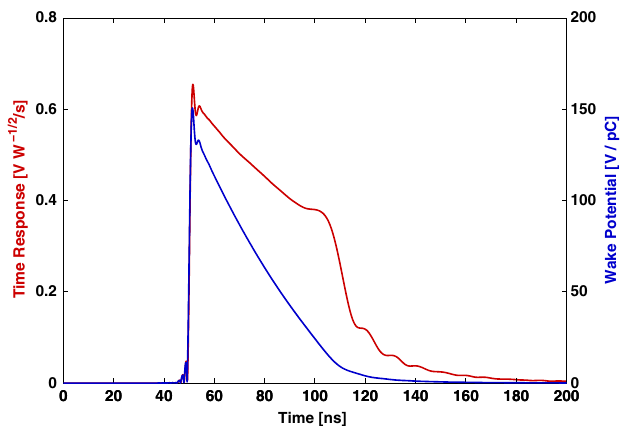
FIG. 3. Complex magnitudes of the time response function for the port excitation (red) and wake potential